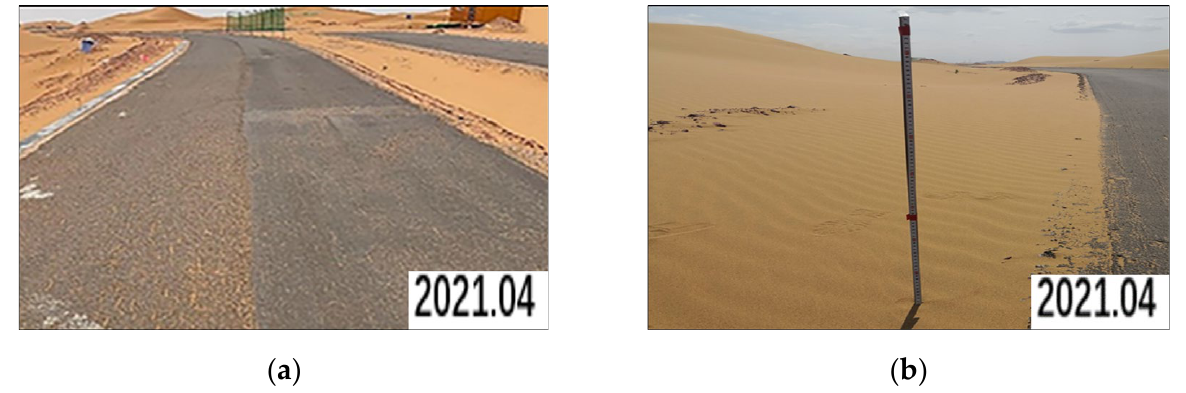
Figure 14. Sand accumulation of the highway in flat terrain ( a ) distribution of sediment ( b ) vertical measurement.